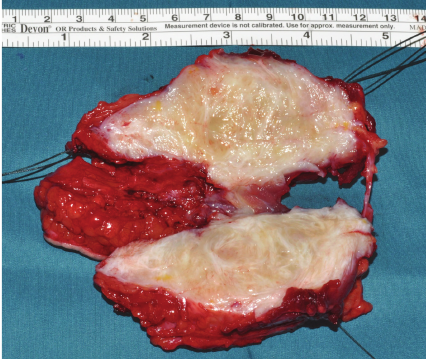
Figure 6: Resected tumor cut